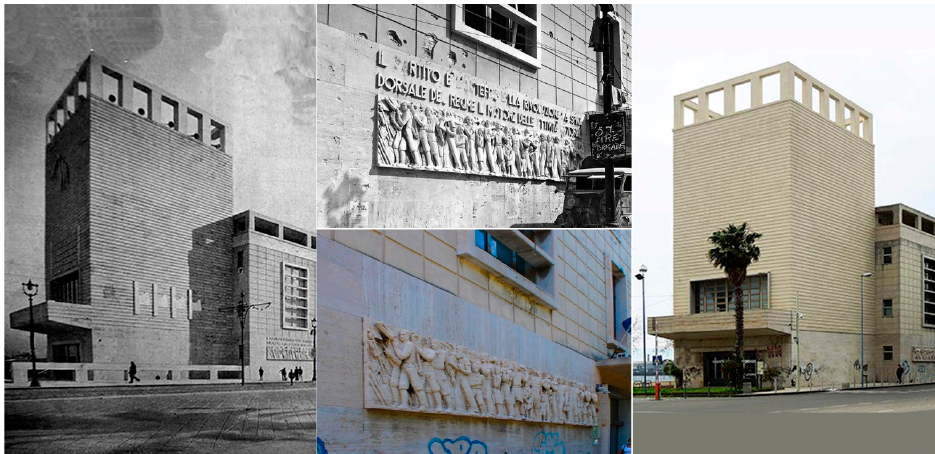
Figure 13. The transformations of the 1980s: the plastering of the travertine tower.